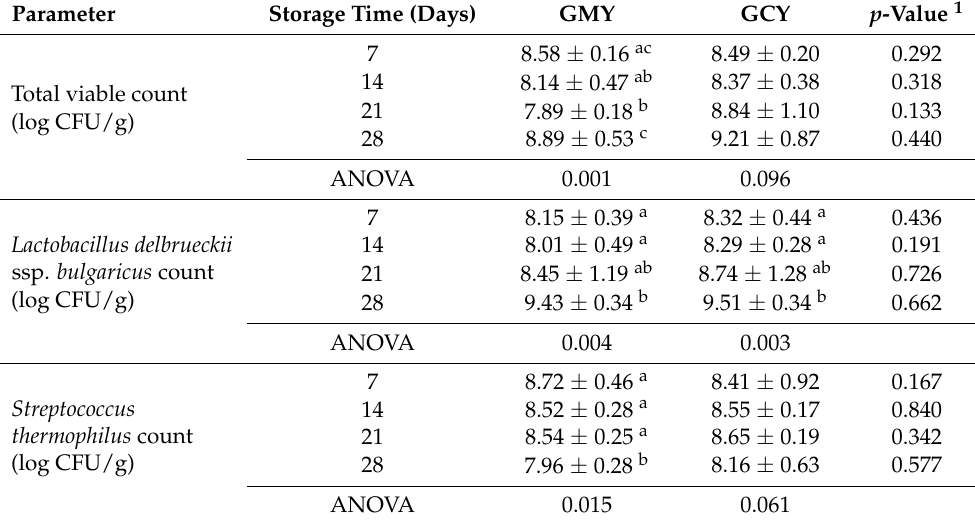
Table 5. Mean values ± standard deviation for total viable, Lactobacillus delbrueckii ssp. bulgaricus and Streptococcus thermophilus counts in goat milk yogurt (GMY) and goat colostrum yogurt (GCY) during cold storage (n = 4).